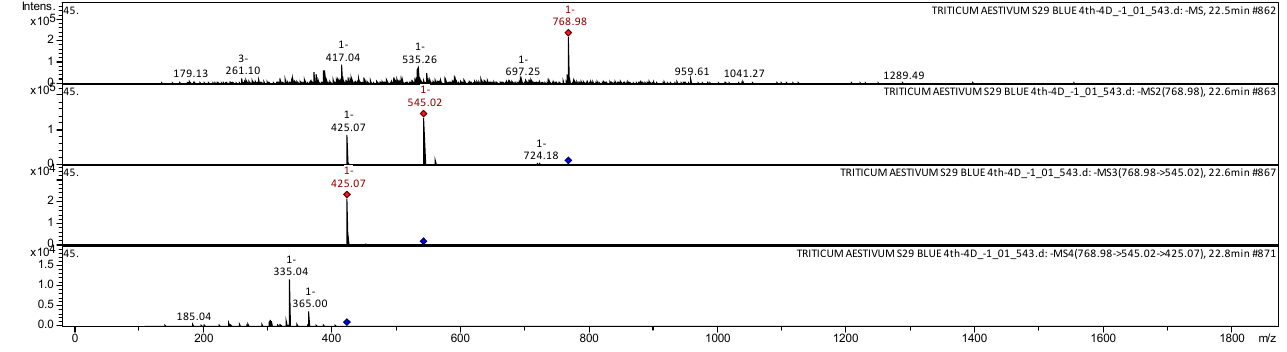
aestivum grains, m/z 768.98. aestivum grains, m / z